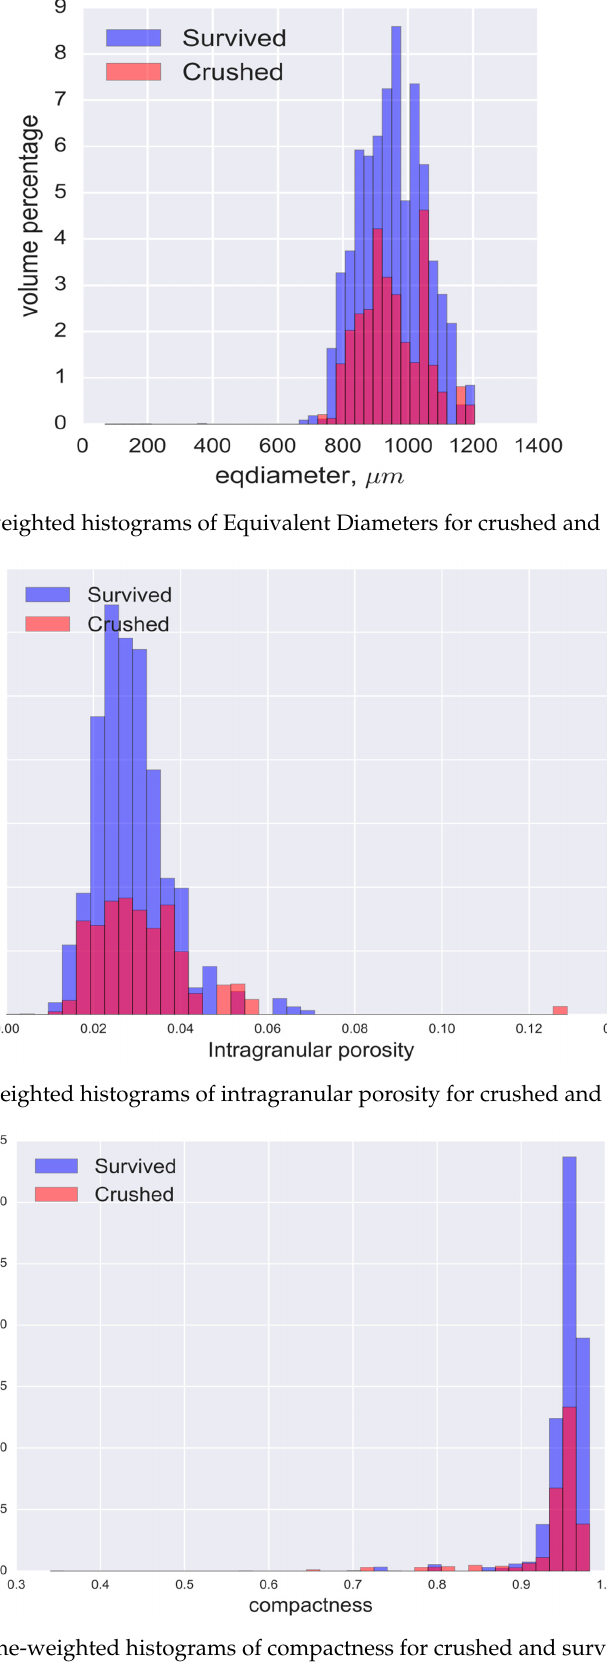
Figure 18. Volume-weighted histograms of compactness for crushed and survived particles. Table 2. Kolmogorov–Smirnov two-sample test for features of survived and crushed particles.